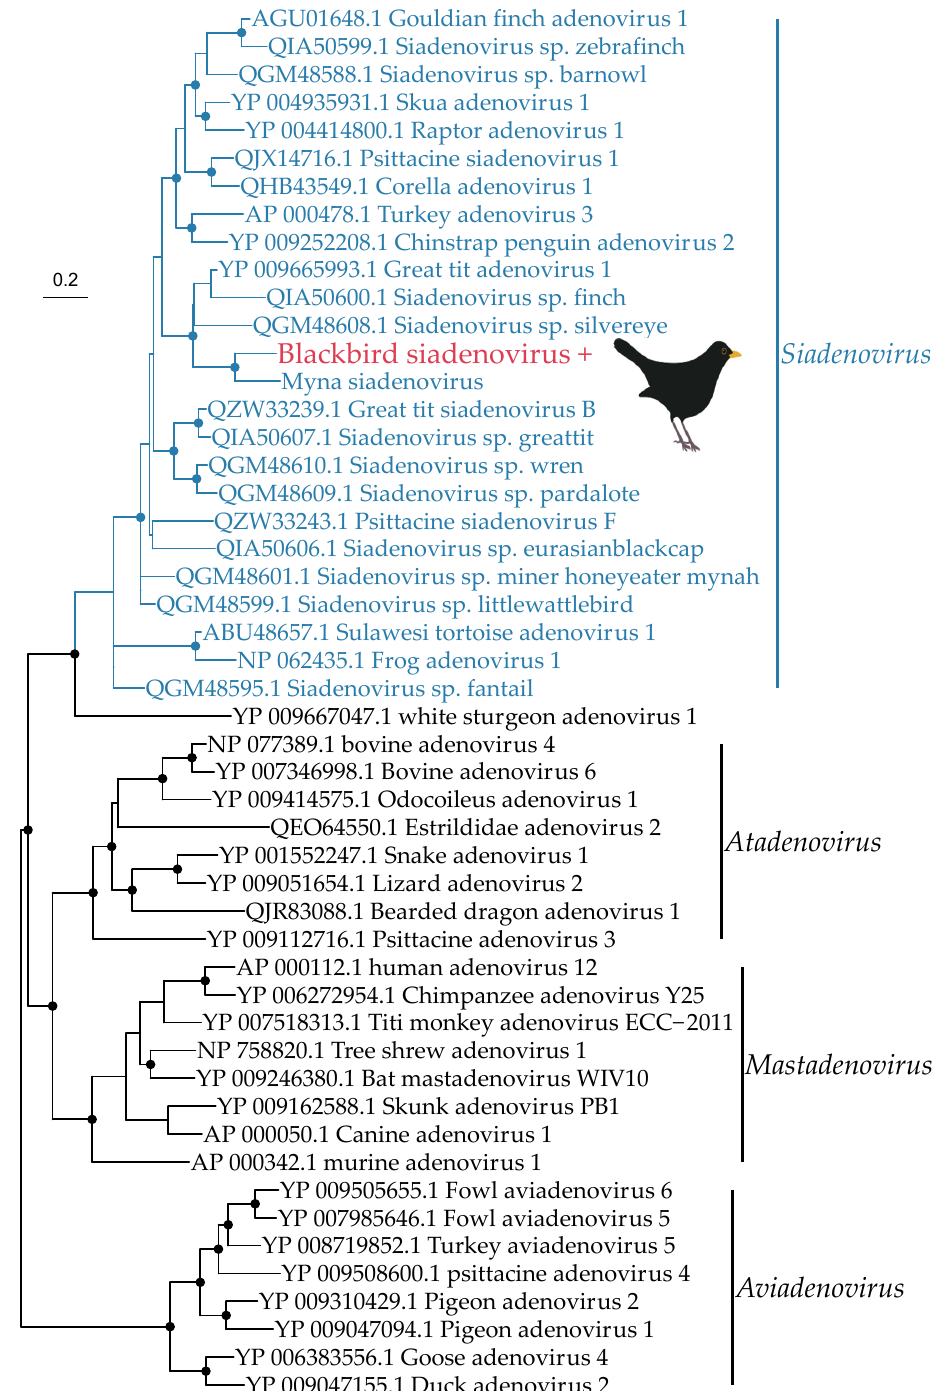
Figure 5. Phylogeny of the Adenoviridae based on the DNA polymerase gene (alignment length of 773 amino acids). The virus from this study (blackbird siadenovirus) has a ‘+’ after the name and is shown in red, and the genus that this virus belongs to ( Siadenovirus) is shown in blue. Related viruses and their genera are shown in black. Black circles on nodes show bootstrap support values of more than 90%. Branches are scaled according to the number of amino acid substitutions per site, shown in the scale bar. The tree is midpoint rooted. Great tit siadenovirus B and psittacine siadenovirus F have not been designated a species classification by ICTV at the time of publication. Bird images in all tree figures by Michelle